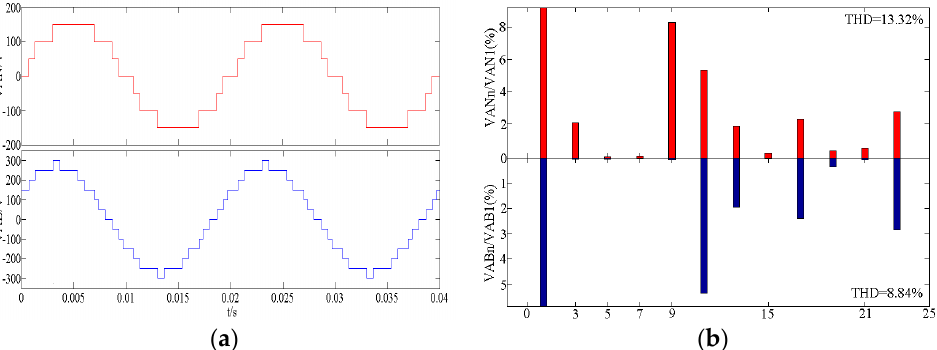
Figure 5. Simulation waveform based on A waveband when U 1 = 3.15. ( a ) Simulation waveforms of phase and line voltages. ( b ) Spectrum distribution of phase and line voltages.